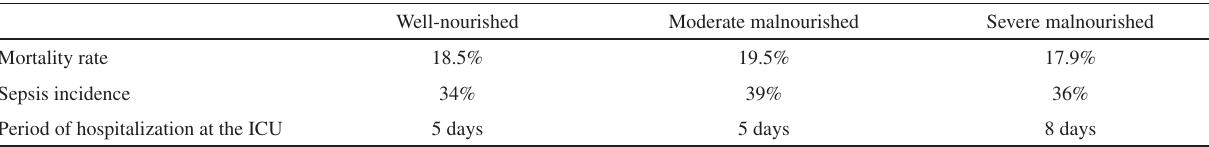
Table 1 - Mortality rate, sepsis incidence and the period of hospitalization at the ICU in well-nourished, moderate malnour- ished and severe malnourished patients